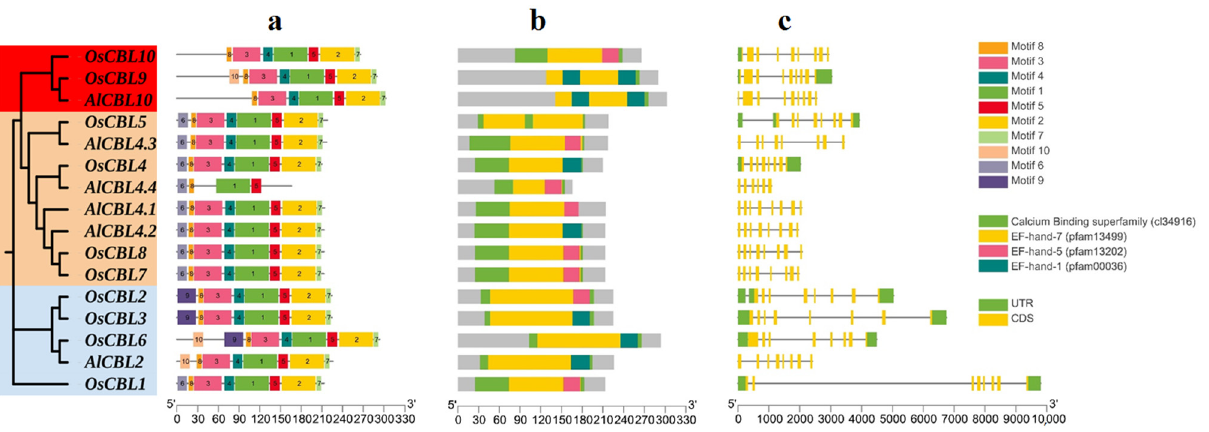
Figure 3. Structure analysis of AlCBL gene family. Distribution of conserved motifs ( a ), functional domains ( b ), and exon/intron ( c ) in AlCBL and OsCBL family members.